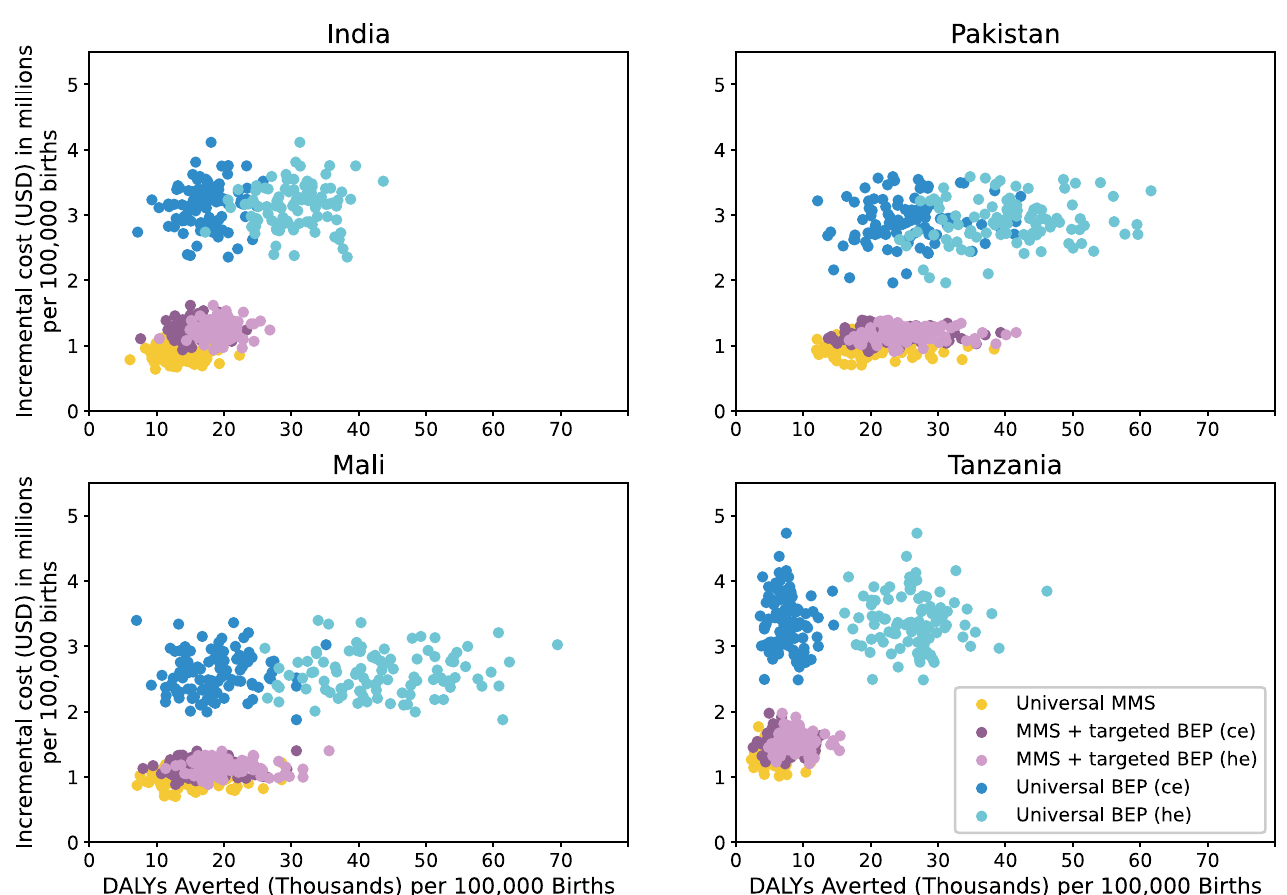
Fig 6. Incremental cost and DALYs averted among the first 2 years of life per 100,000 births for each simulated scenario relative to the baseline scenario in each modeled location. � Each point in this figure represents one of the 100 simulation runs performed, each of which used varying parameter values within the parameter UIs used in our model. BEP, balanced energy protein; ce, scenarios with current evidence effects for BEP; DALY, disability-adjusted life year; he, scenarios with hypothesized effects for BEP; MMS, multiple micronutrient supplementation; UI, uncertainty interval.